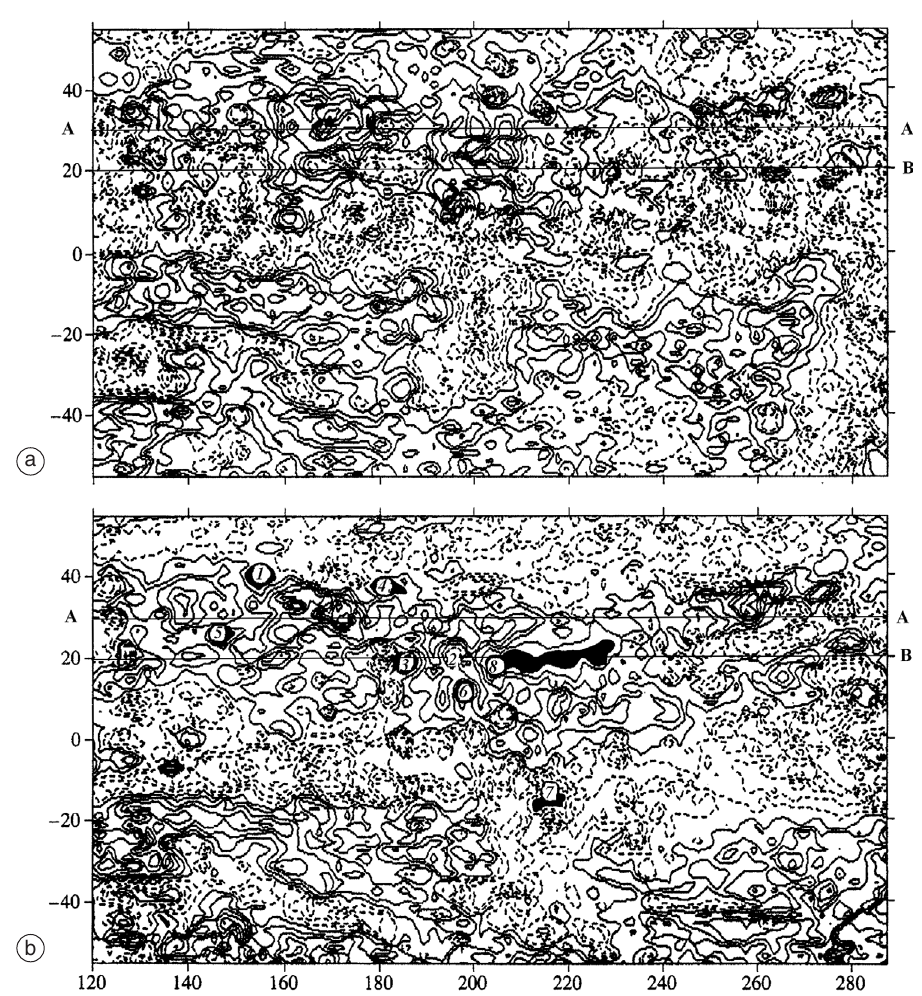
Fig. 1a,b. Spatial structure (a) of the scalar magnetic anomaly field ∆ B a and (b) of the vertical component ∆ Z a obtained from the MAGSAT satellite data for the Pacific Ocean. a) Solid lines denote positive values of the anomaly magnetic field, dotted lines show negative values. Contour interval of 2 nT. b) Results of the spectral analysis of the magnetic field profile along satellite pass over the Pacific Ocean area using maximum entropy method. Magnetic anomaly for tectonic uplifts: 1 – Shatsky; 2 – Hawaiian; 3 – Mid-Pacific Ocean; 4 – Hess; 5 – Marcus; 6 – Line-15; 7 – Tuamotu; 8 – Molokai